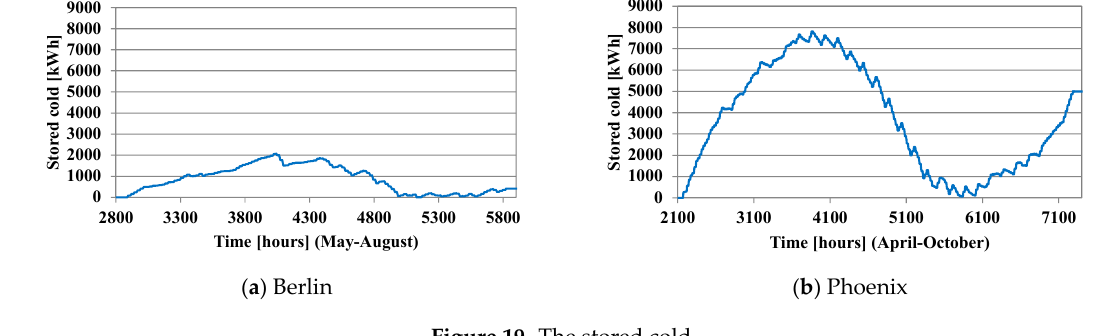
Figure 19. The stored cold.